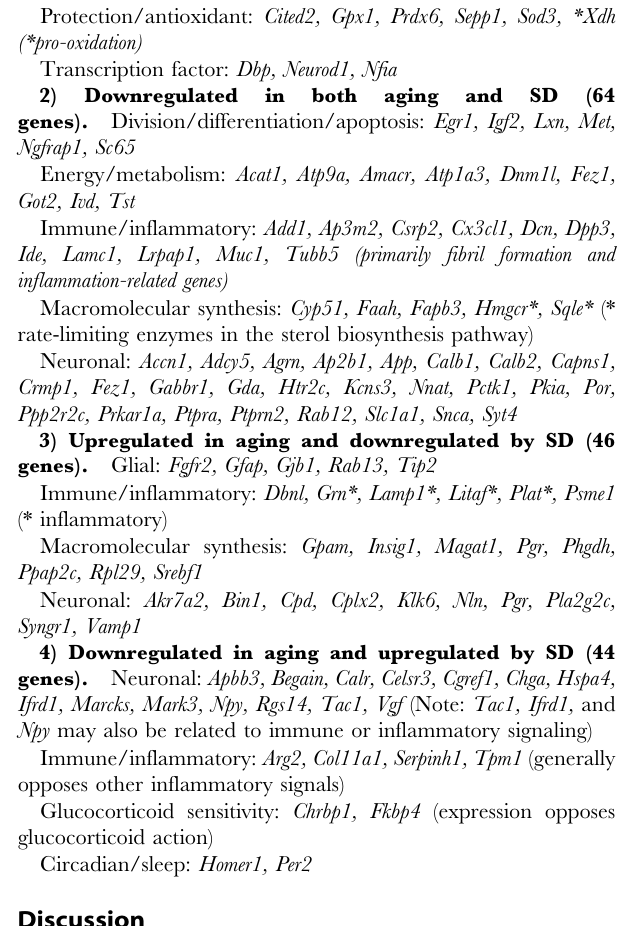
SD. Functional overrepresentation analysis (see Methods) was possible (Fig. 5C) for genes uniquely regulated by SD (456 genes) or Aging (403 genes). Aging showed a selective upregulation of pathways related to transcription, lipid metabolism, and Ca 2 + signaling. Further, downregulated categories were almost exclu- sively related to neuronal function. Interestingly, sleep deprivation appeared to also downregulate a strong, but different, cohort of neuronal genes (Fig. 5C lower right), suggesting that SD and aging may have additive influences on brain function. Upregulated exclusive SD genes included processes related to protein handling and degradation, as well as well-characterized upregulation of stress hormone stimulus